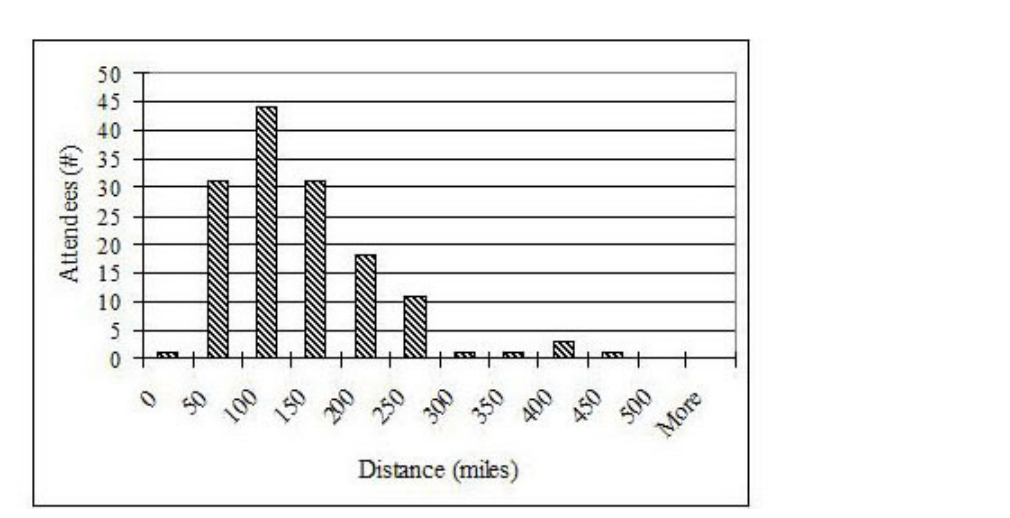
Fig. 4. Distribution of herring attendee